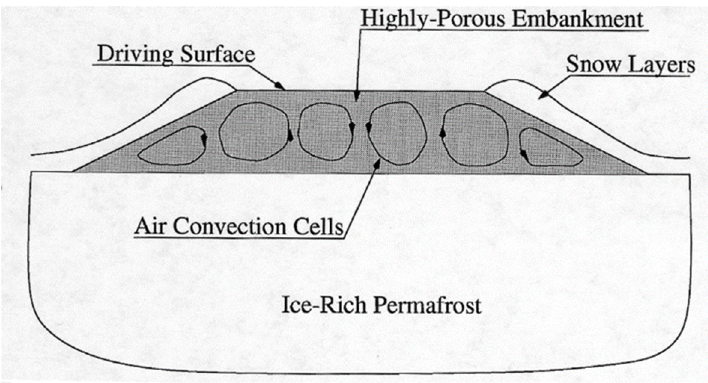
Figure 1. Pattern of pore-air circulation in an air convection embankment (ACE) (Goering, 1998 [3]).